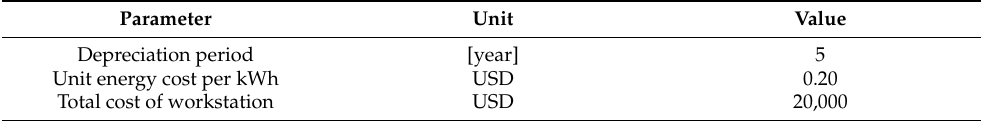
Table 5. Economic parameters of a research experiment.